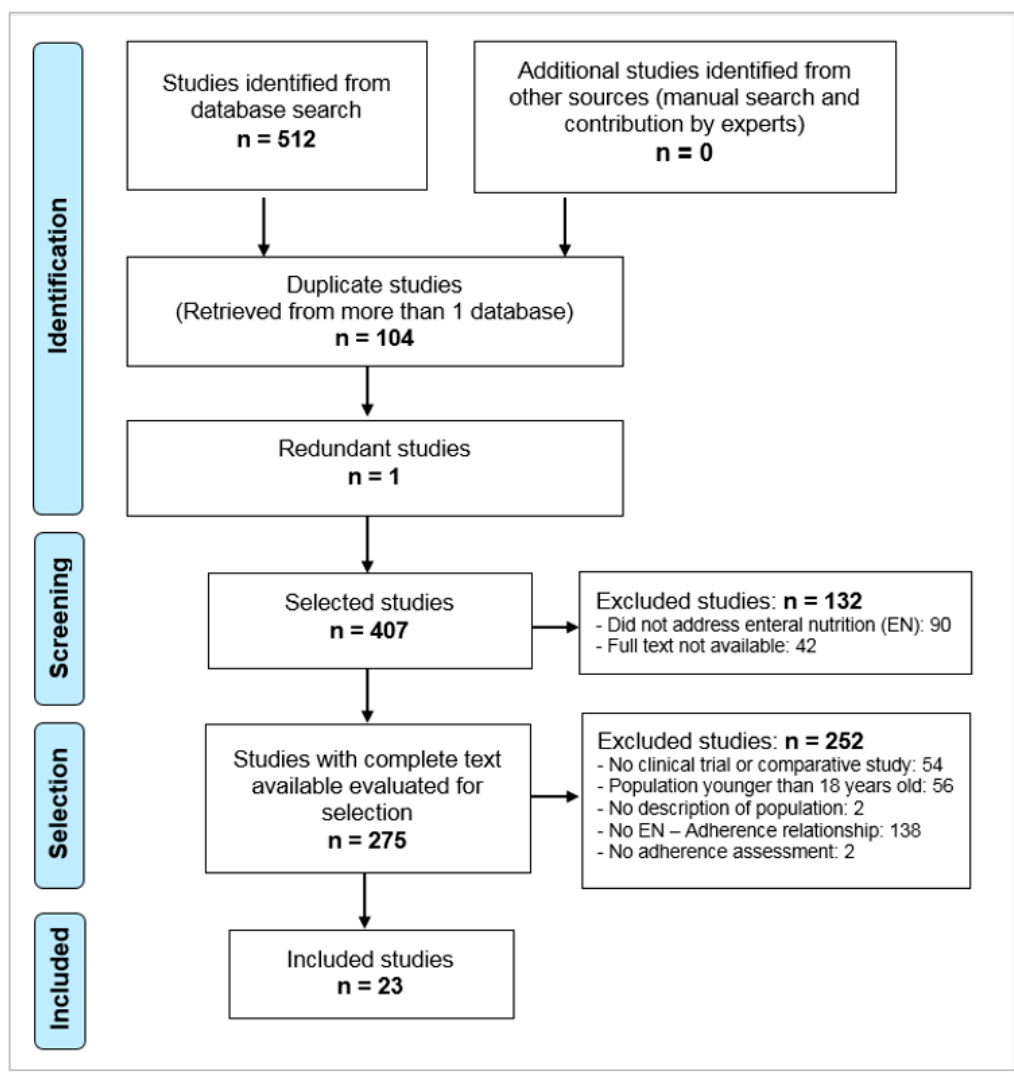
Figure 1. Selection procedure of the studies.